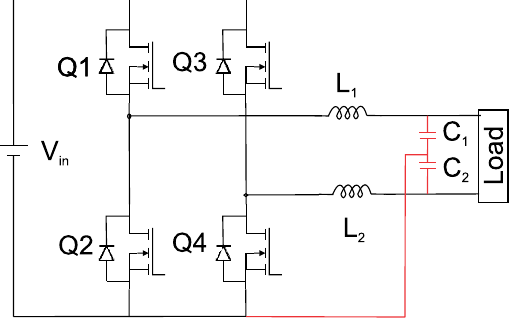
Figure 14. Configuration proposed in [88].